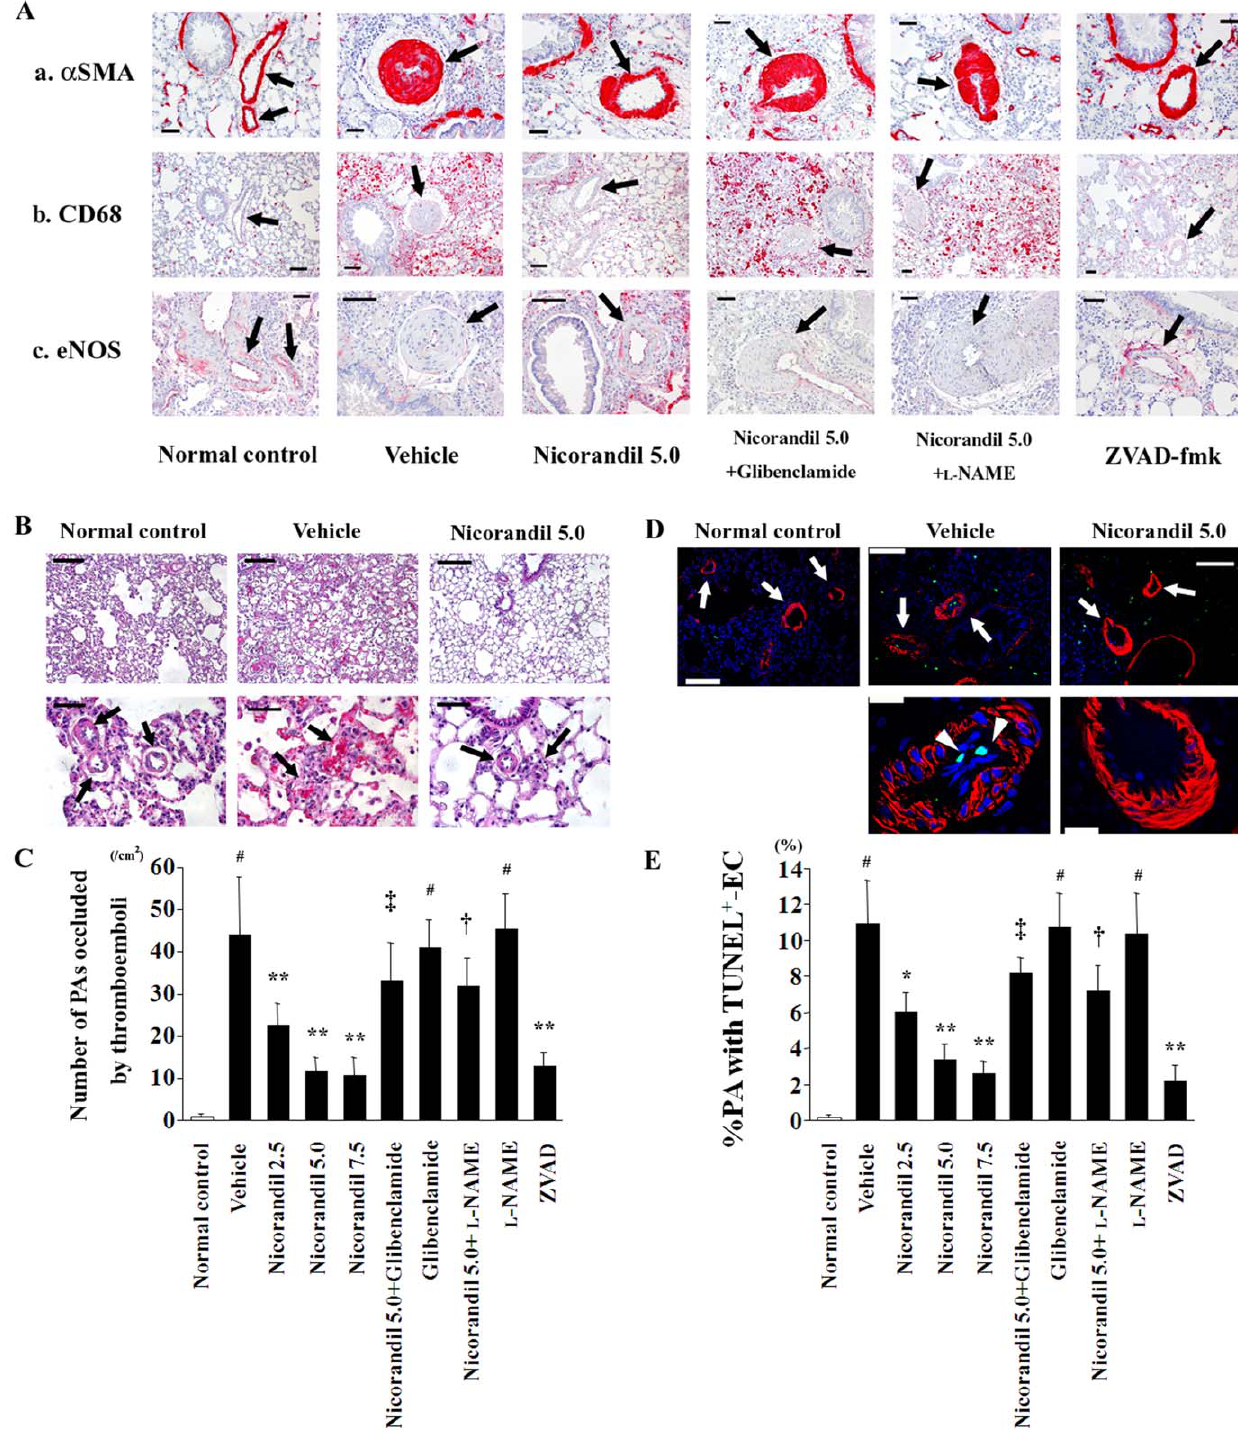
Figure 2. Nicorandil improves the histopathological findings of MCT-injured lungs. ( A ) Immunohistochemical staining for a SMA ( a ), CD68 ( b ), and eNOS ( c ) in lung sections are shown. Histopathologically, MCT injury induced the thickened medial wall of PAs (arrows) that was composed of a SMA-positive cells, the recruitment of CD68-positive macrophages into the perivascular areas, and the deficiency of eNOS expression in the endothelium of the pulmonary vasculature ( see vehicle). Nicorandil and ZVAD-fmk improved these deleterious histopathological changes in the MCT- injured lungs, whereas glibenclamide and L -NAME blocked the effects of nicorandil. Scale bar, 50 m m. ( B ) MCT readily induced thromboemboli formation that occluded the small PAs (arrows; see vehicle), which was attenuated by nicorandil. HE staining. Scale bars, 100 m m (top) and 50 m m (bottom). ( C ) The number of small PAs that were occluded by thromboemboli was counted in the lung sections. ( D ) TUNEL staining with immunofluorescence staining for a SMA in lung sections. MCT readily induced endothelial cell apoptosis (arrowheads) in a number of PAs (arrows; see vehicle), which was attenuated by nicorandil. TUNEL (green); a SMA (red); and nuclei (blue). Scale bars, 100 m m (top) and 20 m m (bottom). ( E ) The